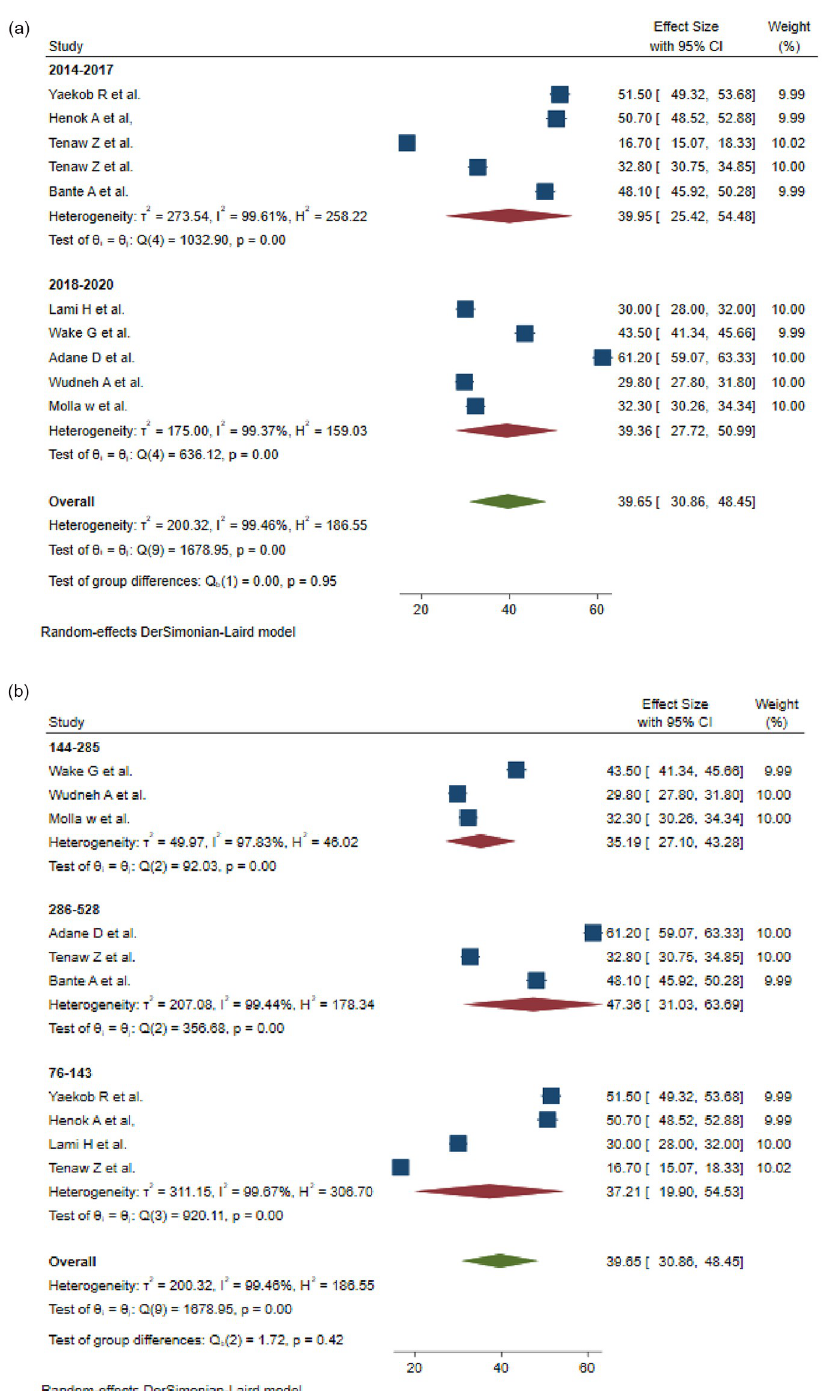
Fig 4. a: Subgroup analysis of the pooled prevalence of practices of active management of the third stage of labor based on the study period. b: Subgroup analysis of the pooled practices of the prevalence of active management of the third stage of labor based on the sample